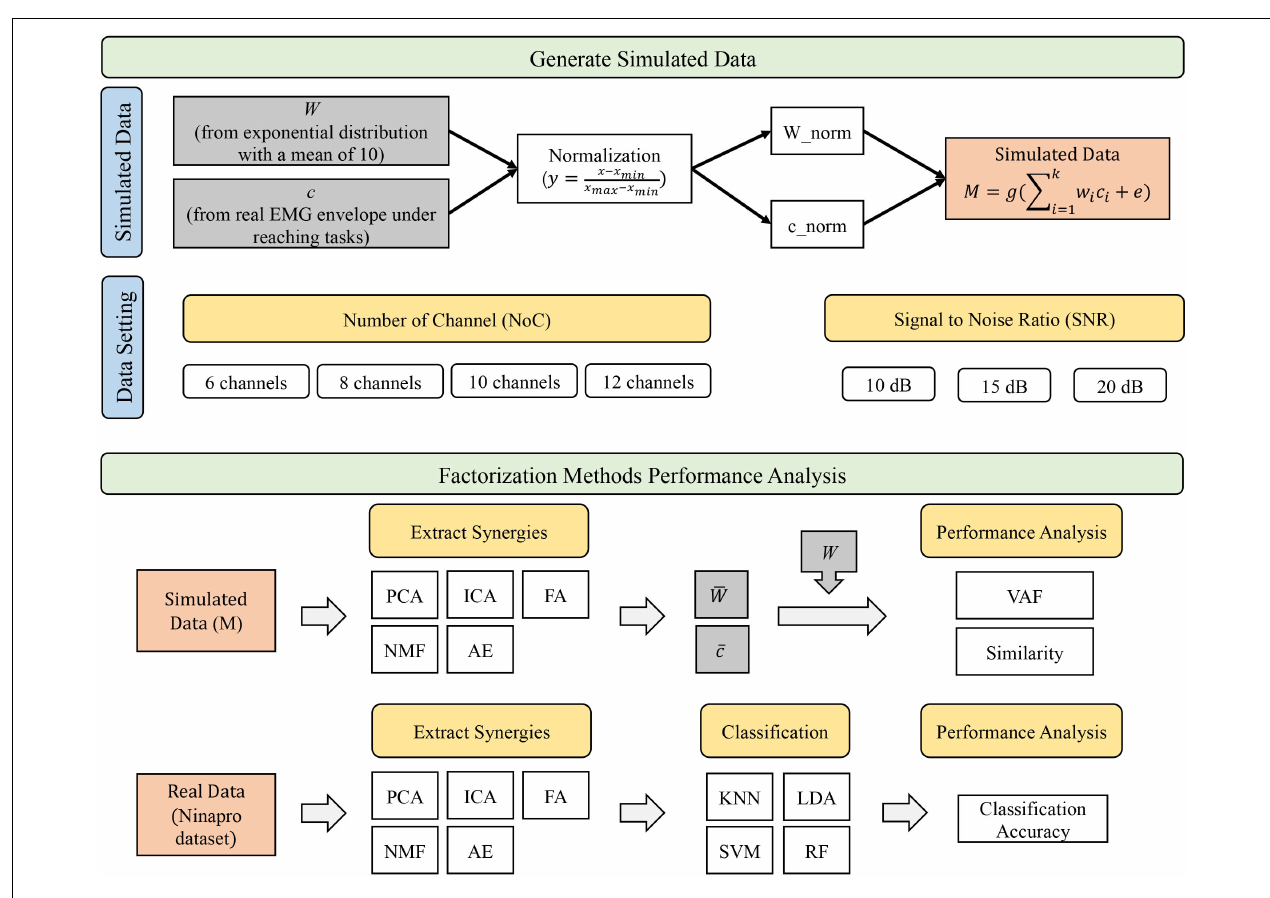
FIGURE 1 | Overview of the study